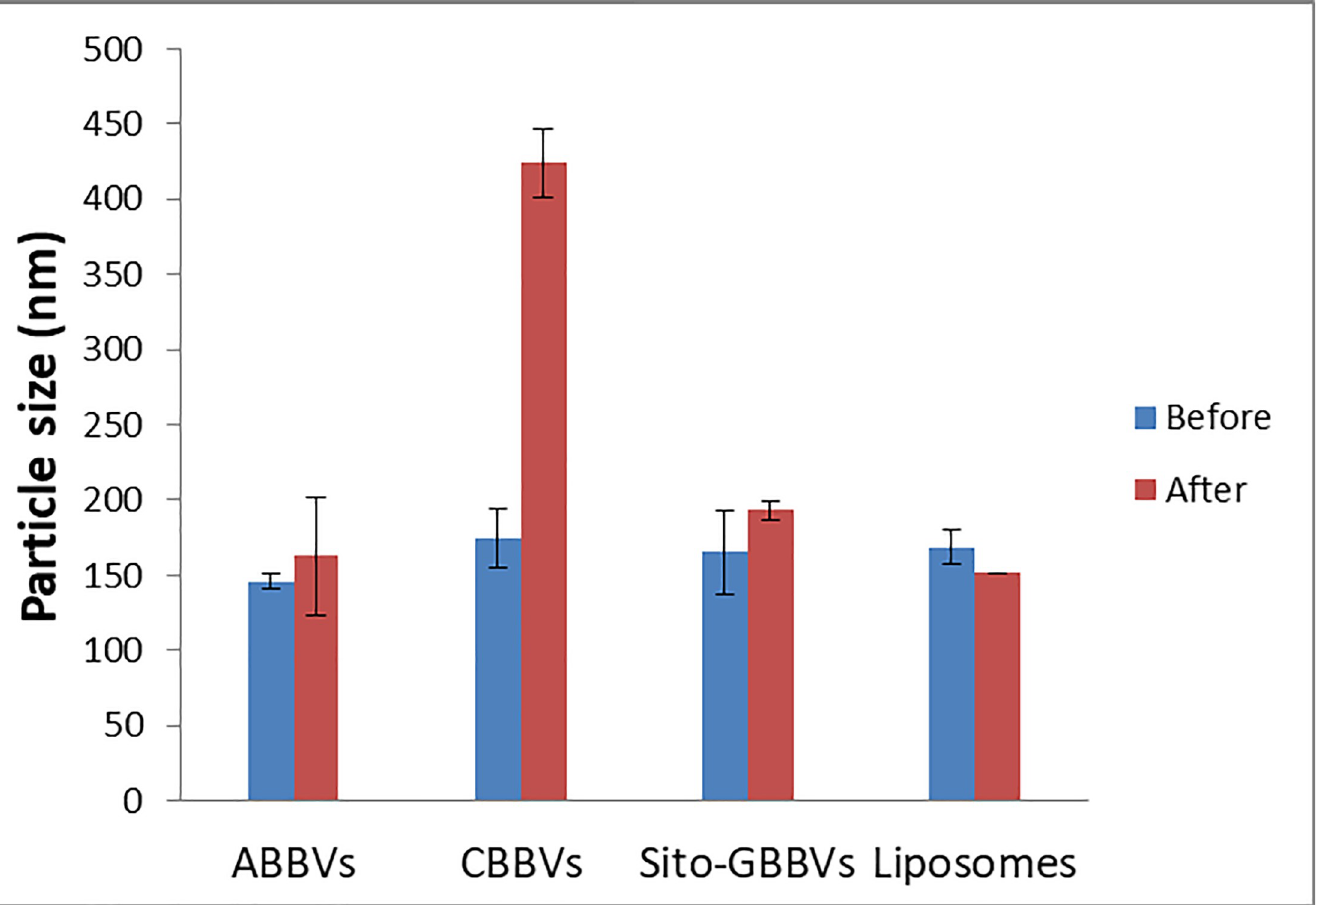
Fig 6. Representative bar chart of particle size of DAC loaded ABBVs, CBBVs, Sito-GBBVs and conventional liposomes before and after 2h incubation with rat serum.